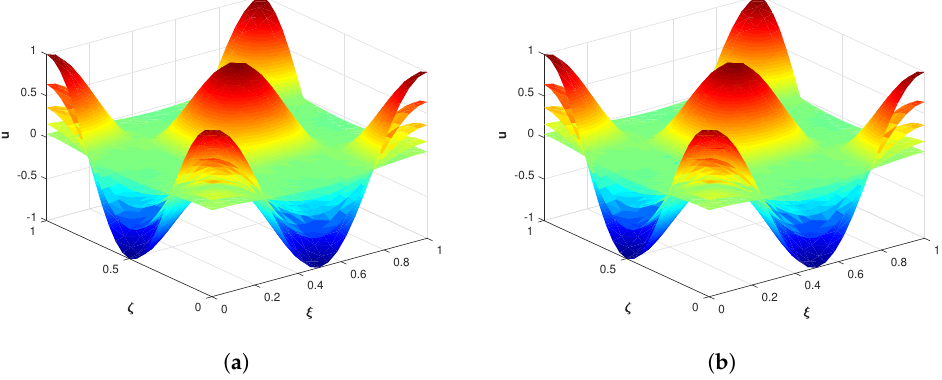
Figure 9. ( a ) Analytic solution of Problem 3 with α = 0.75, N = 625, n = 30, and M = 26. ( b ) Approx- imate solution of Problem 3 with α = 0.75, N = 625, n = 30, and M = 26. The profiles are plotted for t = 0.2 : 0.2 : 1, we see that with an increase in t , the solute concentration increases, and peaks in the profiles have been observed at the center and end points. Similarly, nodes in the profiles have been seen, which show the standing wave behavior of the